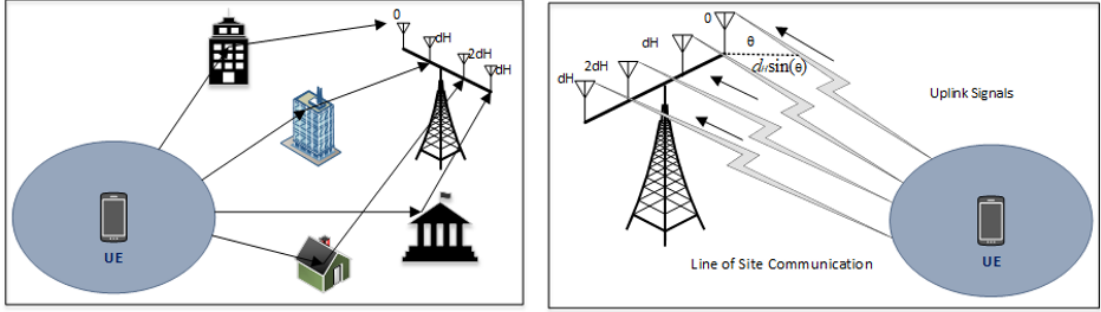
Figure 5. UL communication scenarios for LoS and NLoS signals describing arrival